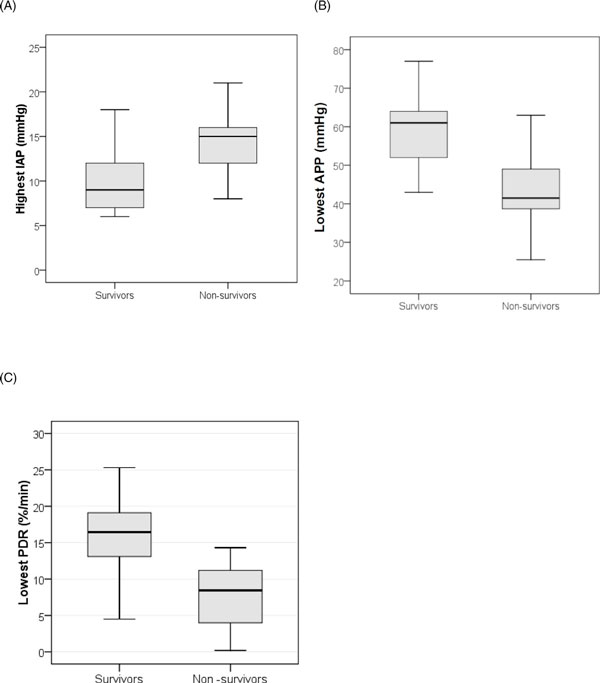
Box plots comparing survivors with non-survivors. (A) Highest IAP values. (B) Lowest APP values. (C) Lowest PDRICG values.